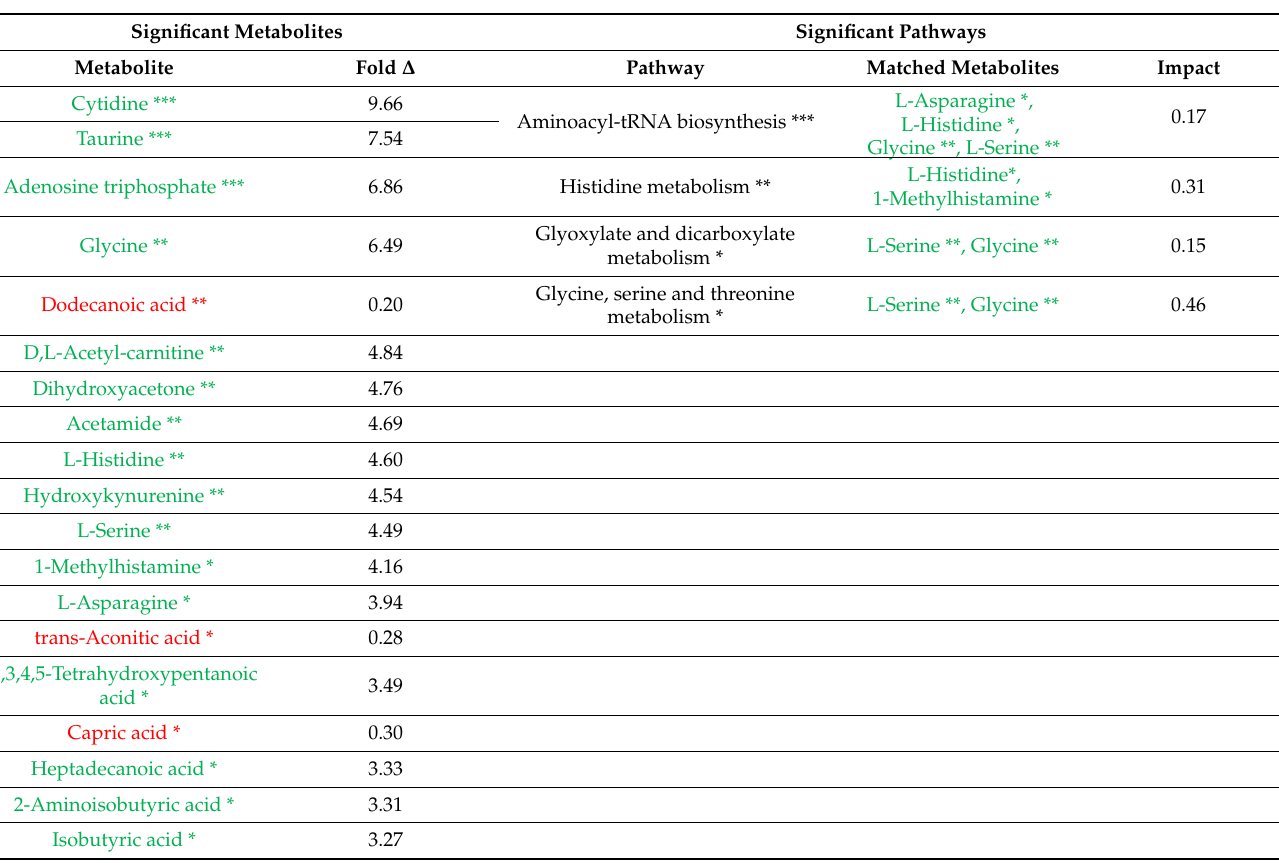
Table 4. Metabolites and their pathways which are different between autism spectrum disorder with neurodevelopmental regression and control